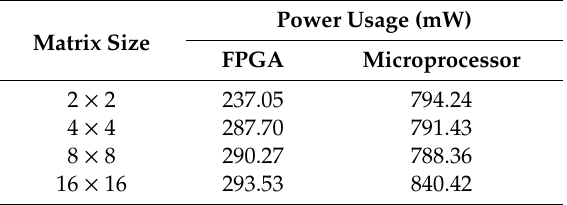
Table 12. Comparison of the power usage between FPGA and microprocessor [41]. Matrix